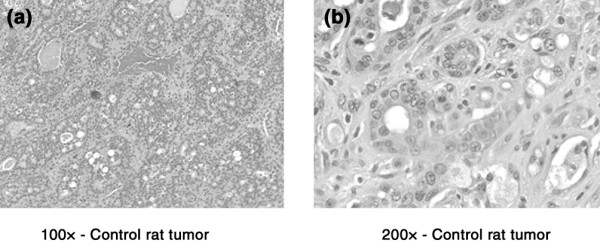
Histological slides showing examples of N-methyl-N-nitrosourea induced mammary tumors in Sprague–Dawley rats fed the control diet (hematoxylin and eosin). Original magnifications: (a) 100× and (b) 200×.